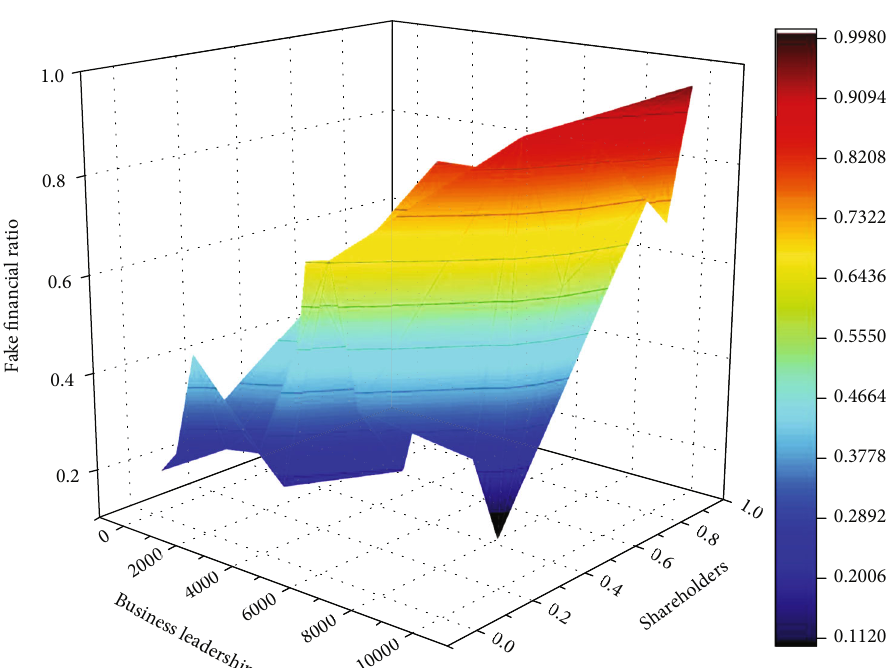
Figure 12: Distribution trend of fi nancial participants and the development of false fi nancial